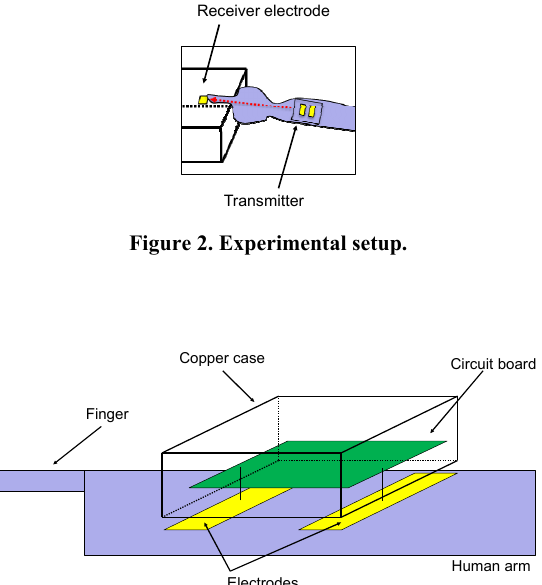
Figure 3. Placement of electrodes and circuit board.